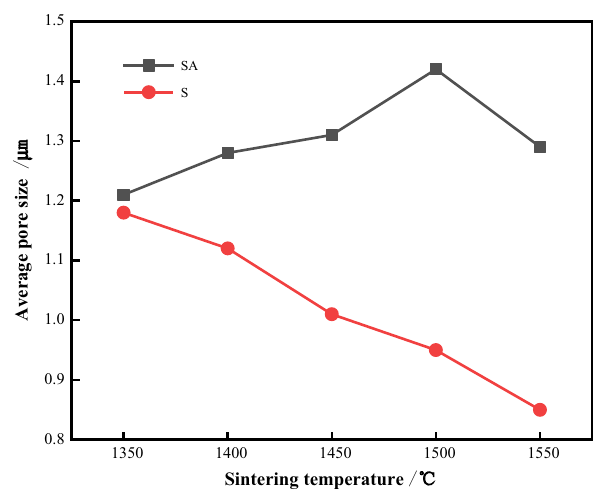
Fig. 6 Average pore size of samples sintered at various temperatures for 2 h in the air